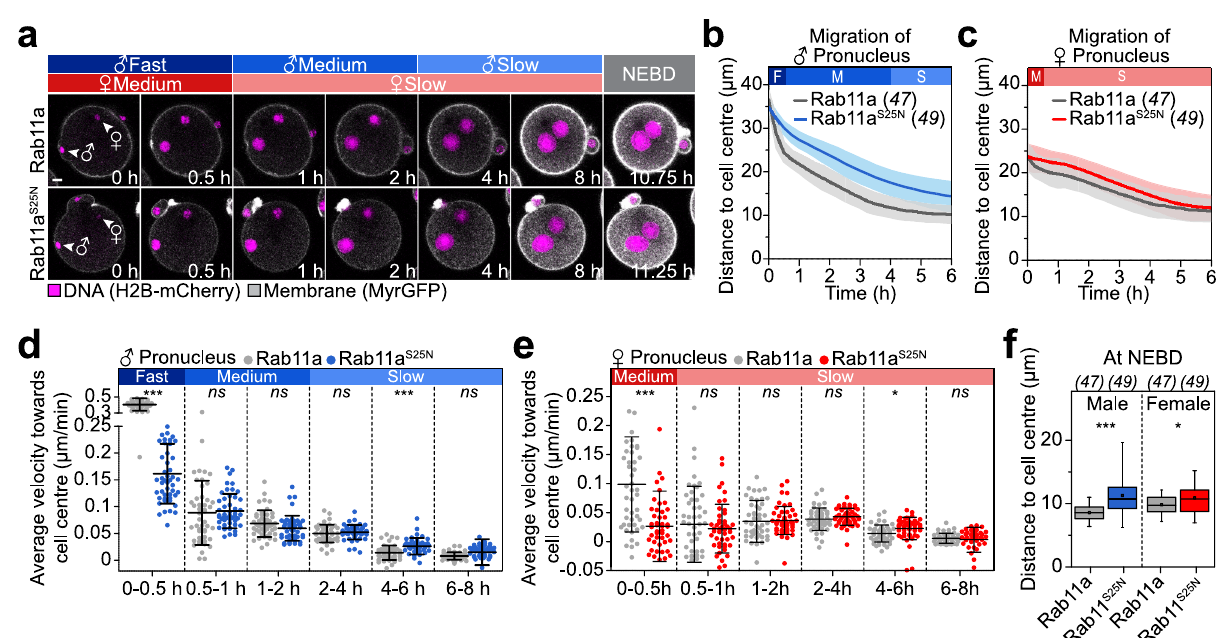
Fig. 3 Rab11a is required for pronuclear migration in the periphery of the zygote. a Three-dimensional time-lapse images of pronuclei (H2B-mCherry) and the cell surface (MyrGFP) in zygotes expressing SNAP-Rab11a or SNAP-Rab11a S25N until nuclear envelope breakdown (NEBD). Female ( ♀ ) and male ( ♂ ) genomes are shown at pronuclear formation (0 h). Phases with respective pronuclear movement speeds are classi fi ed as in Fig. 1a. Scale bar, 10 μ m. The mean distance (thick line) of male ( ♂ , ( b )) and female ( ♀ , ( c )) pronuclei centroids to zygote centre during pronuclear migration in zygotes expressing SNAP-Rab11a or SNAP-Rab11a S25N was calculated from data sets as shown in ( a ). Total number of analyzed zygotes speci fi ed in italics was pooled from six independent experiments. S.d. shown as shaded areas. Statistical plots of average velocities of male ( ♂ , ( d )) and female ( ♀ , ( e )) pronuclei during pronuclear migration in zygotes expressing SNAP-Rab11a or SNAP-Rab11a S25N calculated from ( b ) and ( c ) with the same sample size as in ( b ) and ( c ), respectively. Statistical plots show mean ± s.d. Two-tailed Student ’ s t test was used to test for signi fi cance (from left to right: d p < 0.0001, p = 0.7, p = 0.08, p = 0.4, p < 0.0001 and p = 0.06; e p < 0.0001, p = 0.5, p = 0.8, p = 0.2, p = 0.02 and p = 0.5). We noticed that dominant-negative Rab11a strongly but not completely abolished the fast migration phase of male pronuclei ( d ). Detailed analysis of these early processes suggests that male pronuclei maintain contact to the plasma membrane for twice as long in dominant-negative Rab11a S25N expressing zygotes (Supplementary Fig. 4j, l). Rapid nuclear expansion during this time-period (Supplementary Fig. S1k) together with a mildly delayed fl attening of the cone (Supplementary Fig. 4k) may explain why fast migration may not be fully blocked upon inhibition of Rab11a. Furthermore, we noticed that pronuclei are slightly accelerated in Rab11a-overexpressing zygotes, which means that they move mildly faster over a longer period of time (Fig. S12p, q). f Distance of pronuclei centroids to zygote centre at NEBD in zygotes expressing SNAP-Rab11a or SNAP-Rab11a S25N calculated from data sets in ( a ). Box plot showing median (line), mean (small square), 5th, 95th (whiskers) and 25th and 75th percentile (box) was calculated from the total number of analyzed zygotes speci fi ed in italics. Two-tailed Student ’ s t test was used to test for signi fi cance (male p < 0.0001 and female p =